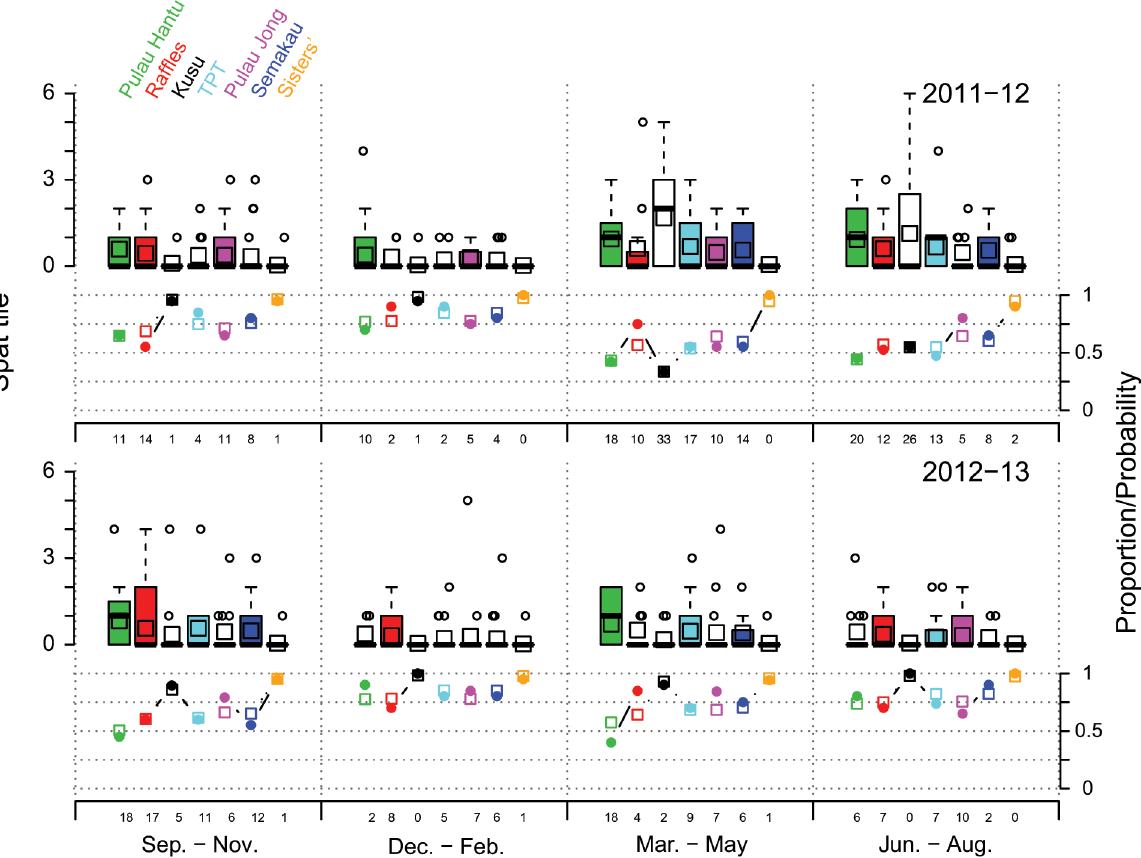
Fig 4. Boxplot of non-Pocilloporidae spat tile -1 for each site (see legend, top left) and sampling period for 2011 – 12 and 2012 – 13. Points above boxes represent outliers outside 1.5 × the interquartile range. Plots below boxplots show the proportion of tiles with zero spat (open circles). Open squares on boxplots and line plot show the predicted values from the final zero-inflated negative binomial model predicted spat tile -1 and predicted probability of a zero count, respectively. Numbers below the proportion/probability x-axes are the total non-Pocilloporidae spat counts for each site and sampling period. Sites were ordered from left to right according to descending rank abundance of non- Pocilloporidae spat over the entire study period.